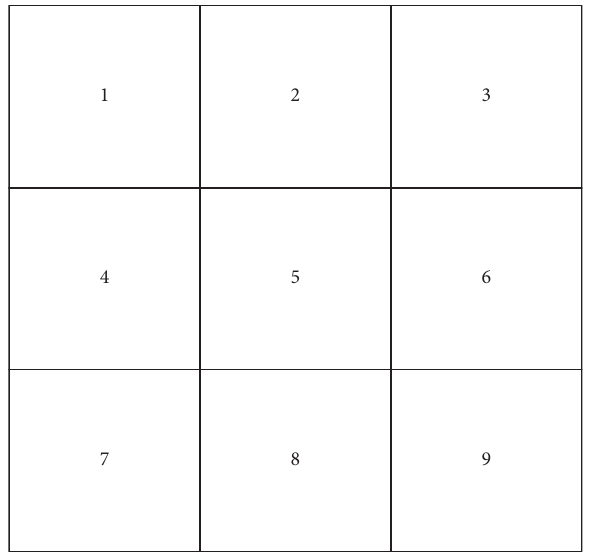
Figure 8: Schematic diagram of target